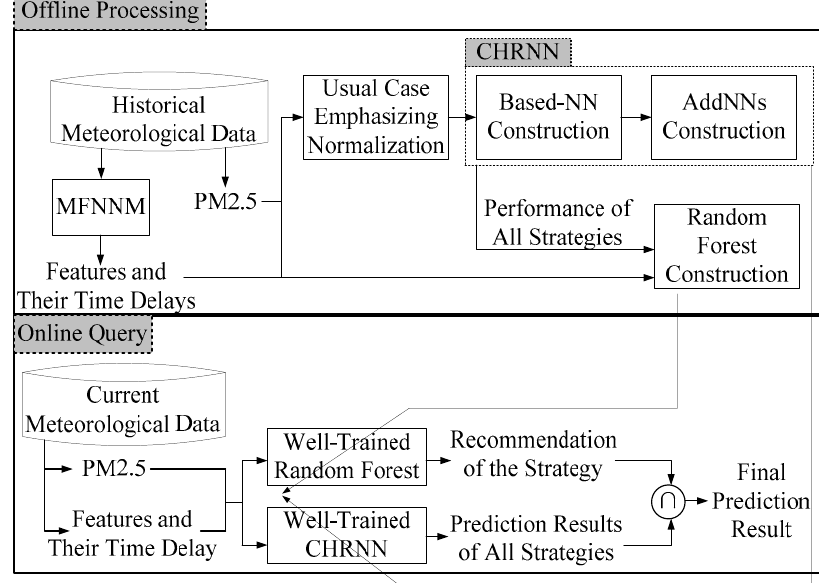
Figure 6. Flow chart of proposed algorithms: (1) identifying suitable predictive features and their time-delaytermsbyusingmodifiedfalsenearestneighbormethod(MFNNM);(2)normalizingparticulate matter 2.5 (PM2.5) time-series values; (3) constructing based-neural network (based-NN); (4) constructing add-on neural networks (AddNNs); and (5) constructing a random forest model to recommend combinational Hammerstein recurrent neural network (CHRNN) implementation